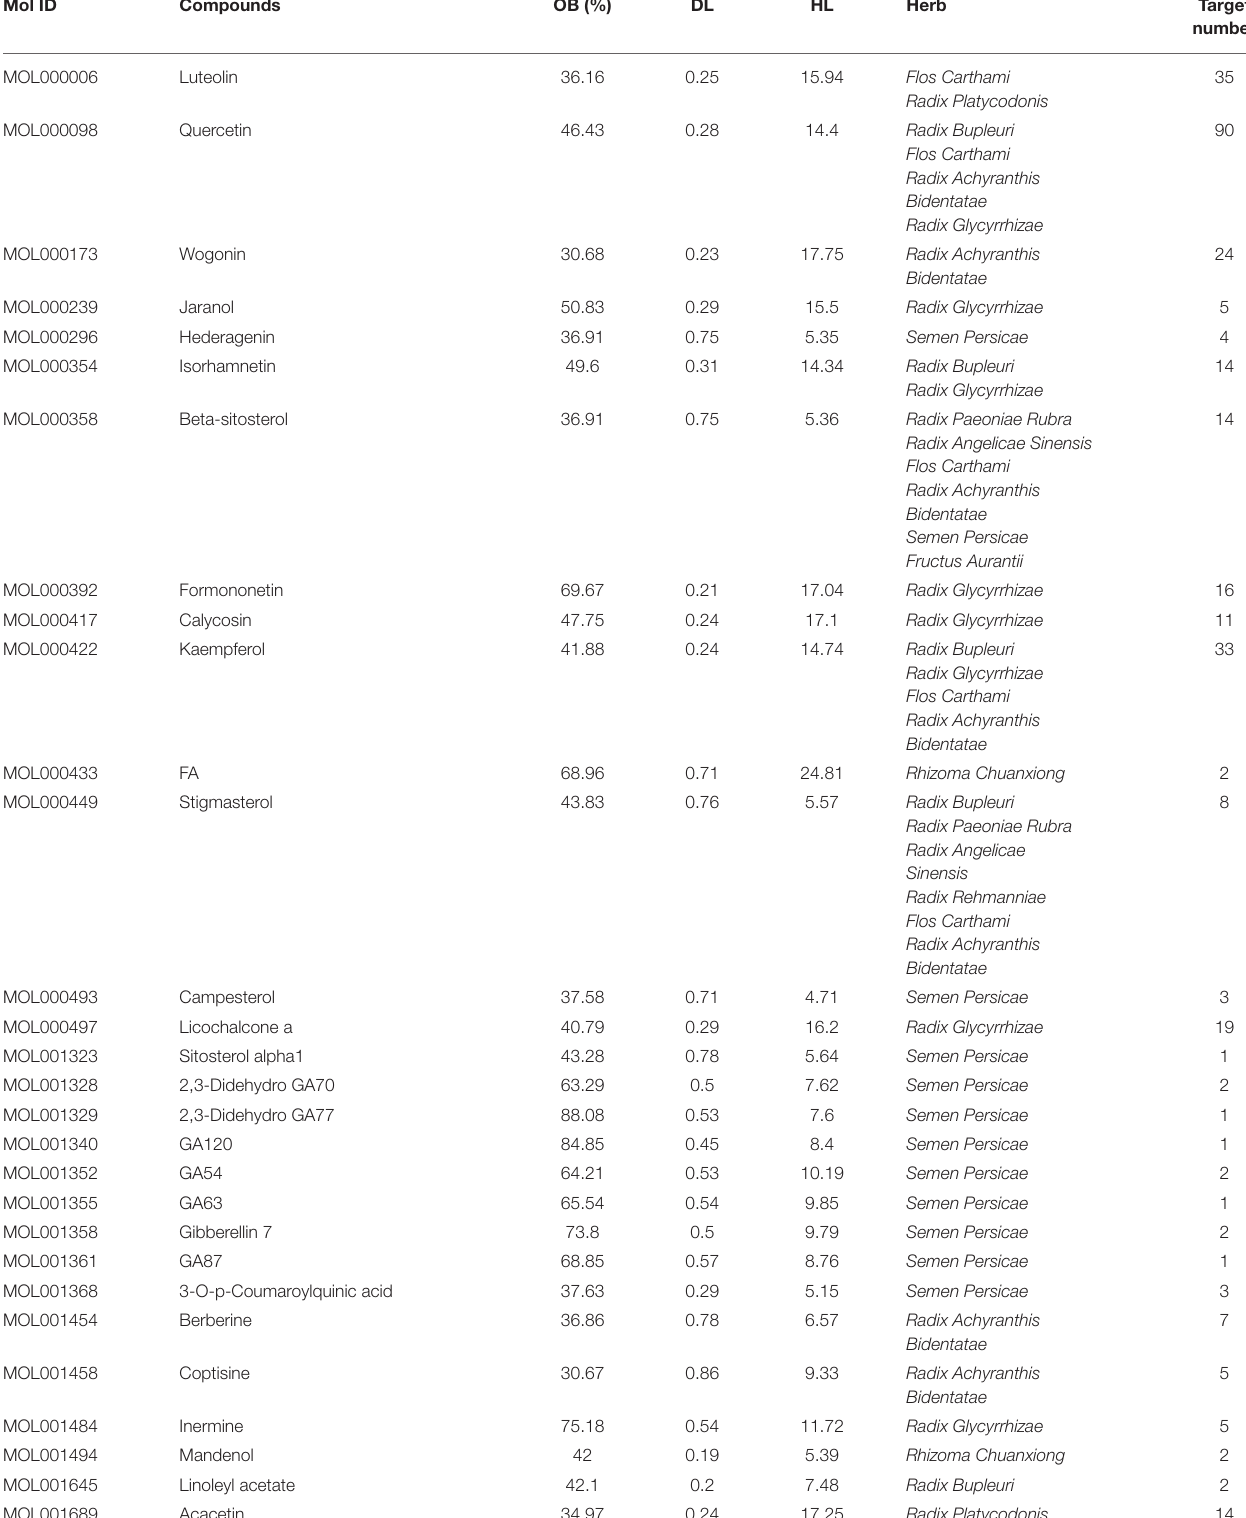
TABLE 1 | The characteristics of effective compounds in Xuefu Zhuyu decoration (XFZYD). Mol ID